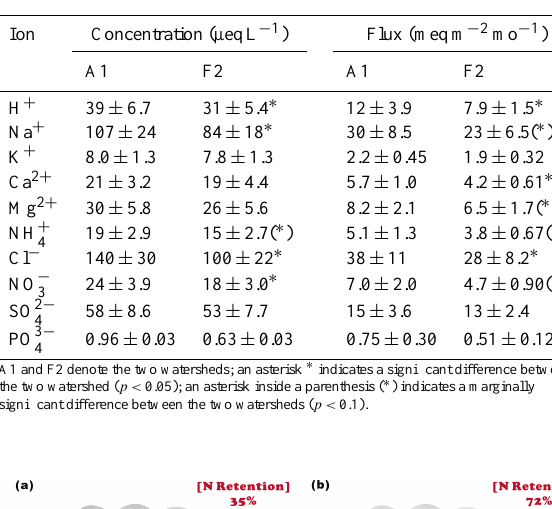
Table 3. Mean ( ± 1SE) monthly ion concentration (volume- weighted from weekly samples) and flux of rainfall.